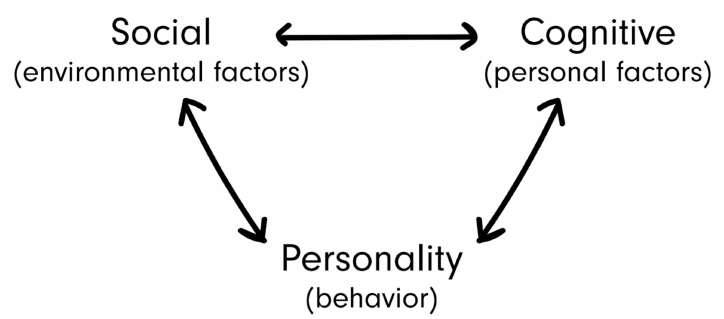
Figure 7. Social cognitive theory. Reproduced from Bandura, A., Human agency in social cognitive theory; published by American Psychologist, 1989.